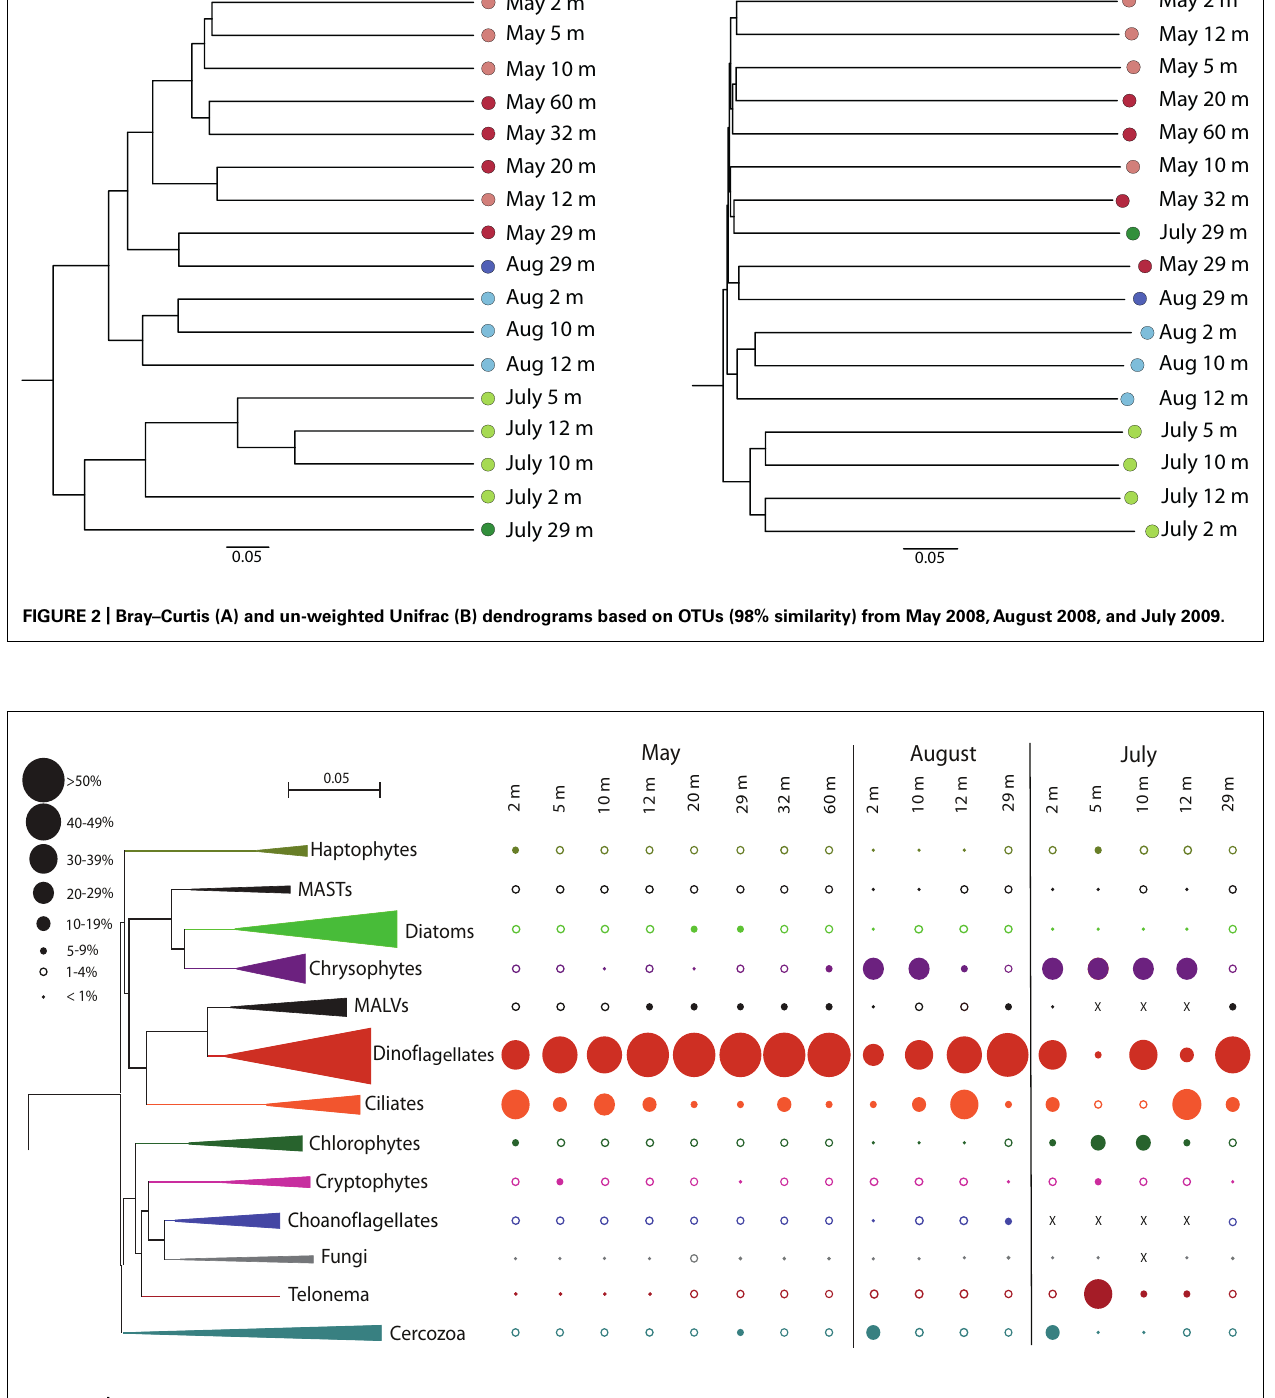
FIGURE 3 | Neighbor Joining eukaryote tree indicating the proportion of each phylum from the water column of LakeA at the three dates. The size of the leaves is proportional to the number of genera within the groups from all samples.The sizes of the circles show proportions of sequence groups from each sample (scale in the upper left